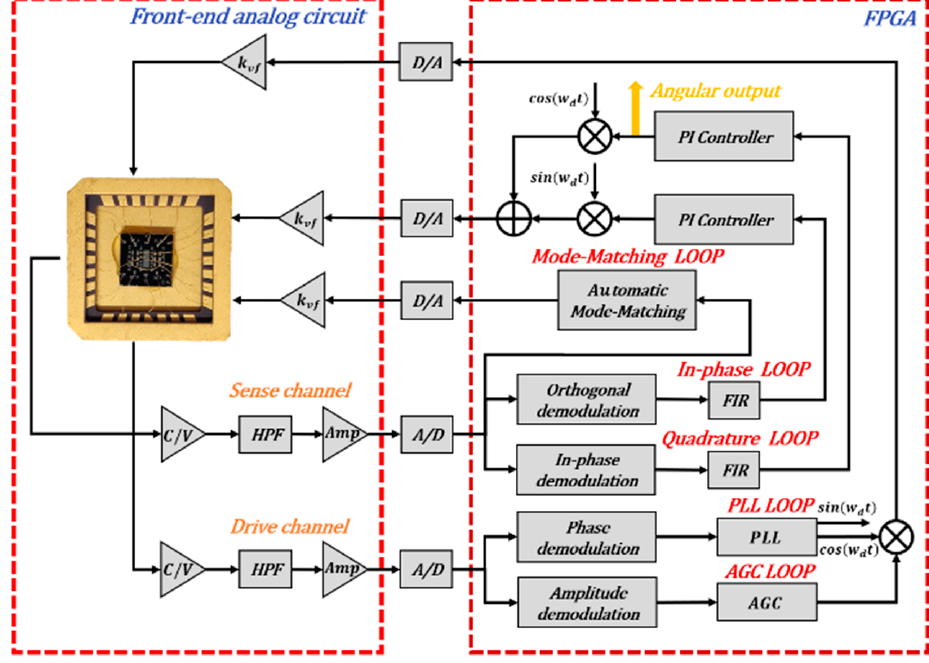
Figure 6. A schematic depiction of the control circuit system for dual-mass TFGs. To characterize the structural characteristics of the dual-mass TFGs, the frequency sweep properties (spanning 3.2 kHz) are detected using a dynamic signal analyzer (Keysight 35670A), and the results are shown in Figure 7. The resonance frequency of the antiphase drive mode is 12,824 Hz, which is 720 Hz-higher than that of the low-frequency in-phase drive mode (12,104 Hz), ensuring the suppression of common modes and the elimination of a parasitical low-frequency in-phase mode. The resonance frequency of the linearly coupled antiphase sense mode is 12,768 Hz, which is 56 Hz-lower than the master frequency of the drive-mode, as demonstrated in Figure 7a. An automatic mode-matching loop is proposed to reduce the frequency splitting between the two modes, and the resonance frequency of the antiphase sense mode is adjusted to 12,823.5 Hz with a negative electrostatic spring effect. It is noted that the resonance frequency difference is inevitable for the sake of a stable vibration. The resonance frequency of the sense mode suffering automatic mode-matching is shown in Figure 7b. The mechanical sensitivity and the signal-to-noise ratio (SNR) of the angular output are dramatically